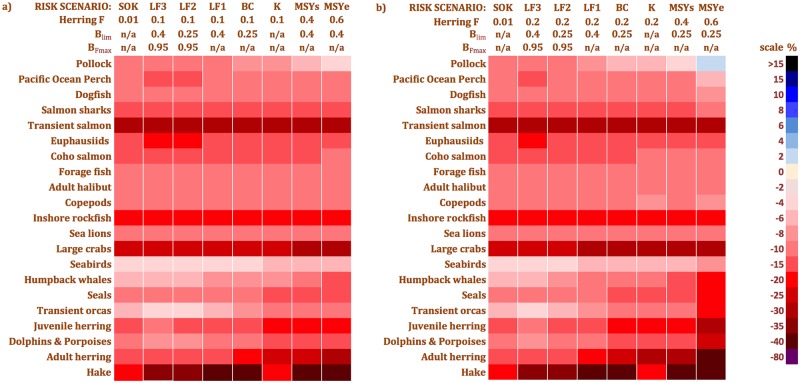
Grand mean minus 0.675 standard deviations (μ—0.675σ) functional group biomass changes showing the risks associated with EwE MSE scenarios.a) Ftarget = 0.1 except SOK (0.01) and the MSYs and MSYe scenarios (0.4 and 0.6, respectively, at the higher Blim) b) Ftarget = 0.2 except SOK (0.01) and the MSYs and MSYe scenarios (0.4 and 0.6, respectively, at the lower Blim).